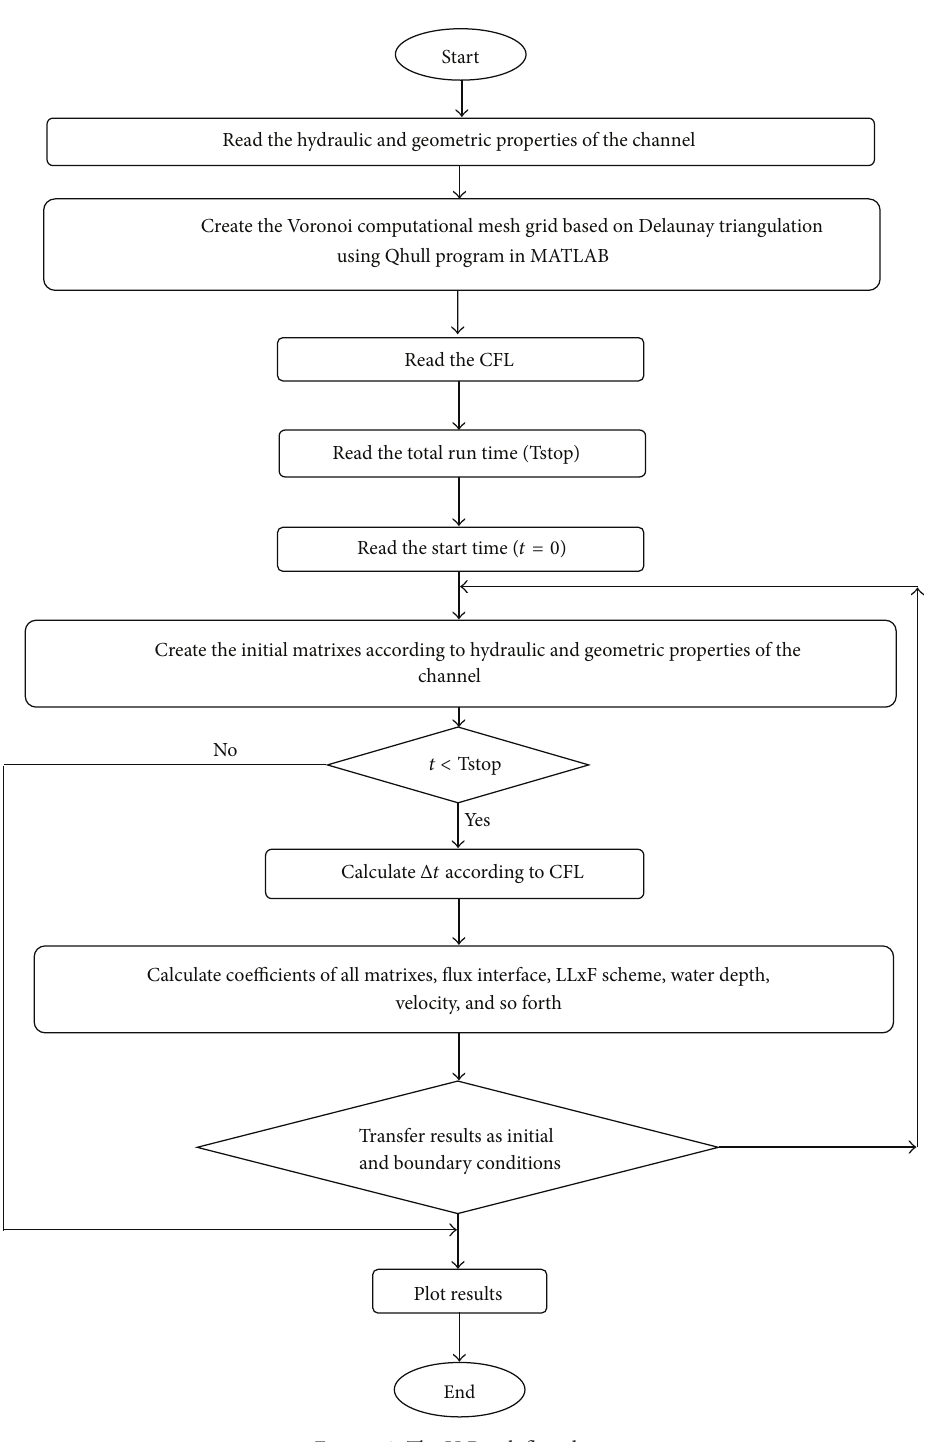
Figure 2: The V-Break